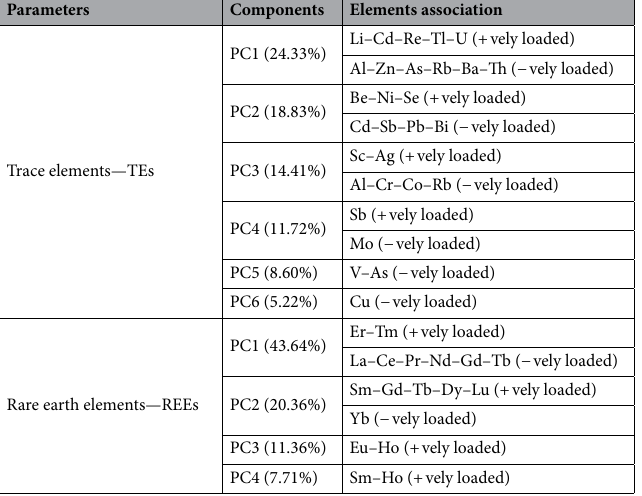
Table 5. Principal component loadings extracted from the geochemical centered log-ratio transformed lake sediments